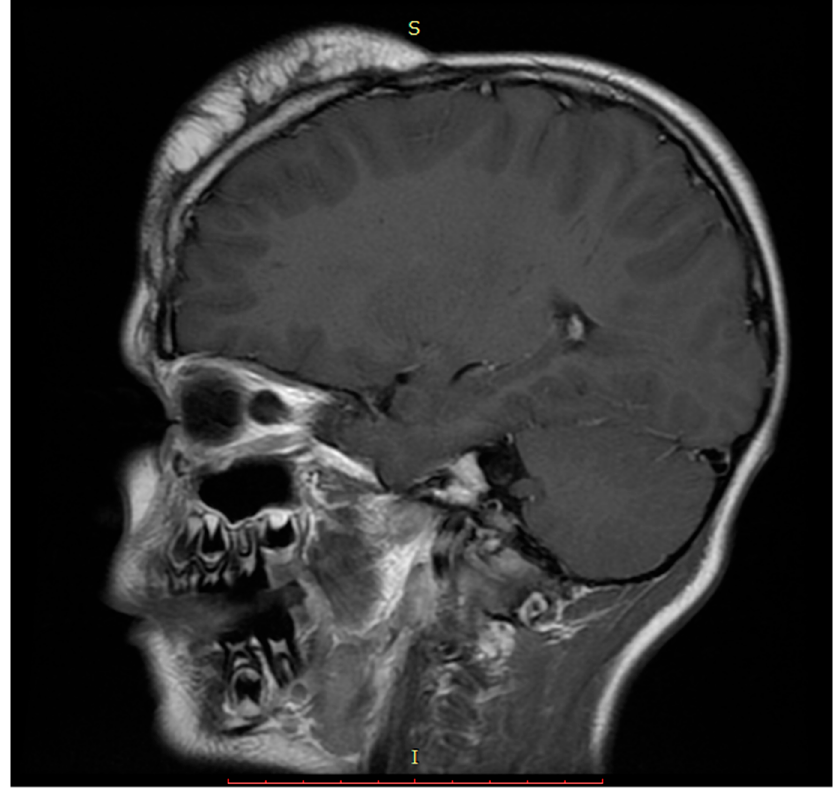
Figure 2. Sagittal T1 magnetic resonance image showing heterogenous lobulated fat in the high frontal scalp.